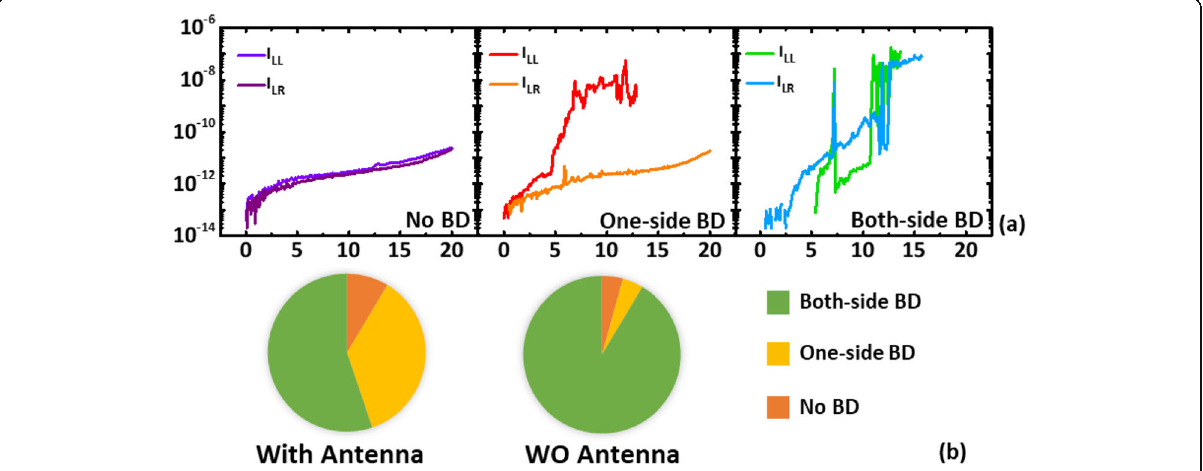
Fig.4 a Different types of breakdown characteristics on the test pairs across a wafer and b comparing the percentage of samples exhibiting distinctive types of breakdown characteristics on device pairs over 60